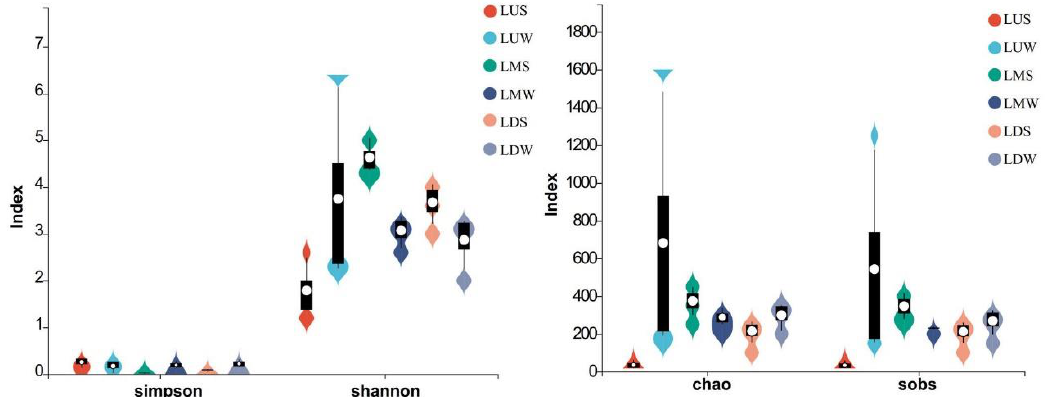
Figure 1. Distribution of alpha diversity estimators of epiphytic bacterial communities on Spartina alterniflora among different groups. LUS: summer samples of upper leaves; LMS: summer samples of middle leaves; LDS: summer samples of lower leaves; LUW: winter samples of upper leaves; LMW: winter samples of middle leaves; LDW: winter samples of lower leaves.